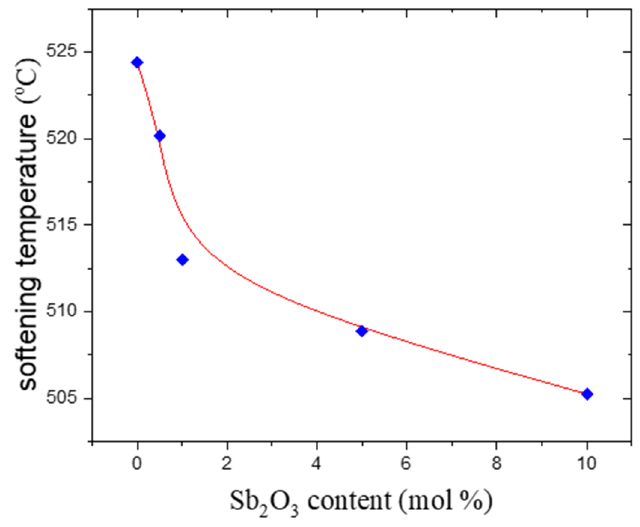
Figure 5. Dependence of the softening temperature on the Sb 2 O 3 contents.